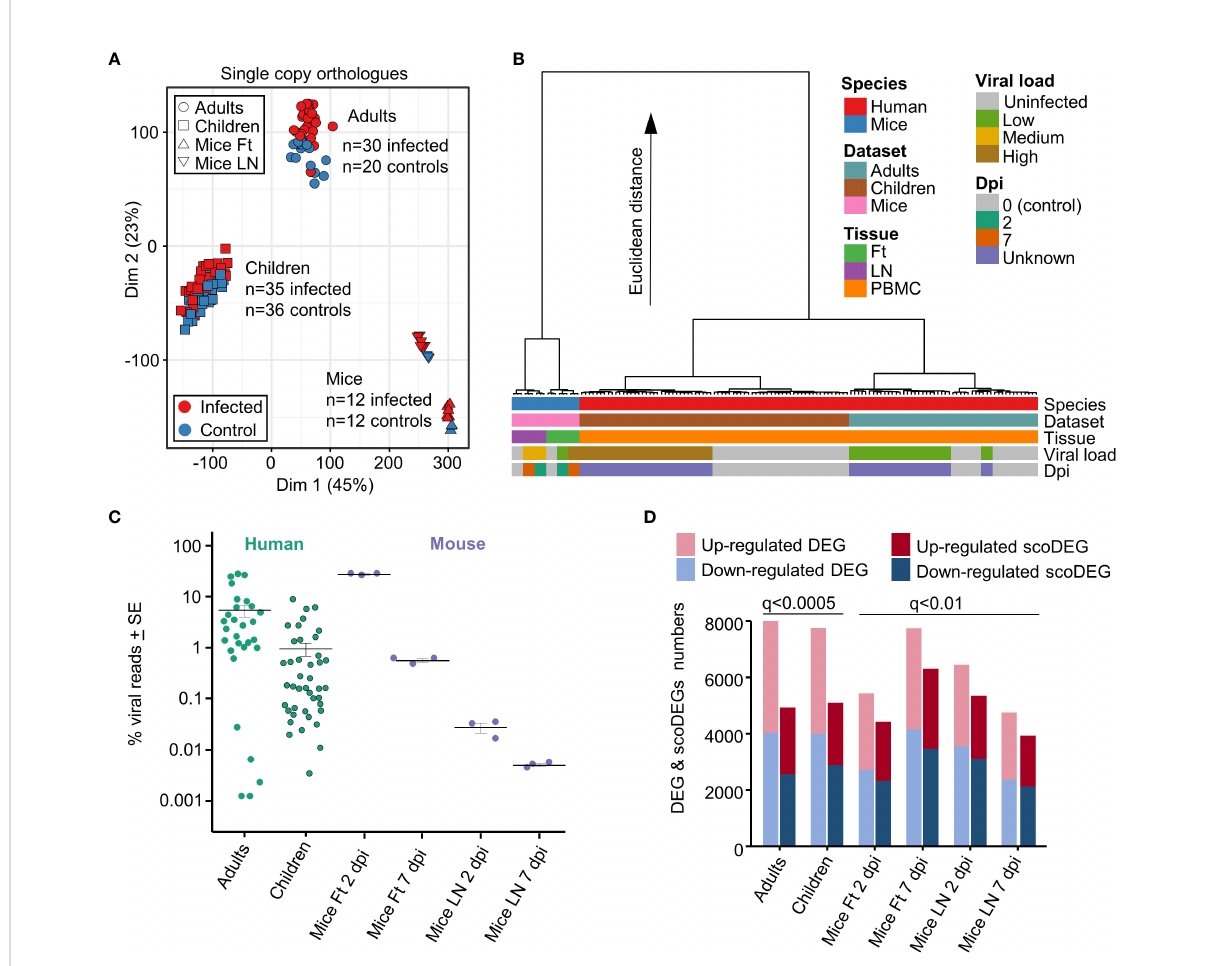
FIGURE 1 Principal component and hierarchical cluster analyses, viral loads, DEGs and scoDEGs. (A) Principal component analysis (PCA) plot (PC1 - Dim1, PC2 - Dim2) for all accessions using all single copy orthologues. (B) Hierarchical cluster analysis using log2 TMM-normalized read counts of the top 500 single copy orthologues ranked by PC1 and PC2 loadings. (C) The number of viral reads in each accession expressed as a percentage of the total number of reads aligning to protein coding genes in the human or mouse genome in the same sample. Cross-bars represent the mean for each group. (D) Histogram showing the number of DEGs and scoDEGs for each group after application of the indicated signi fi cance cutoffs (q,